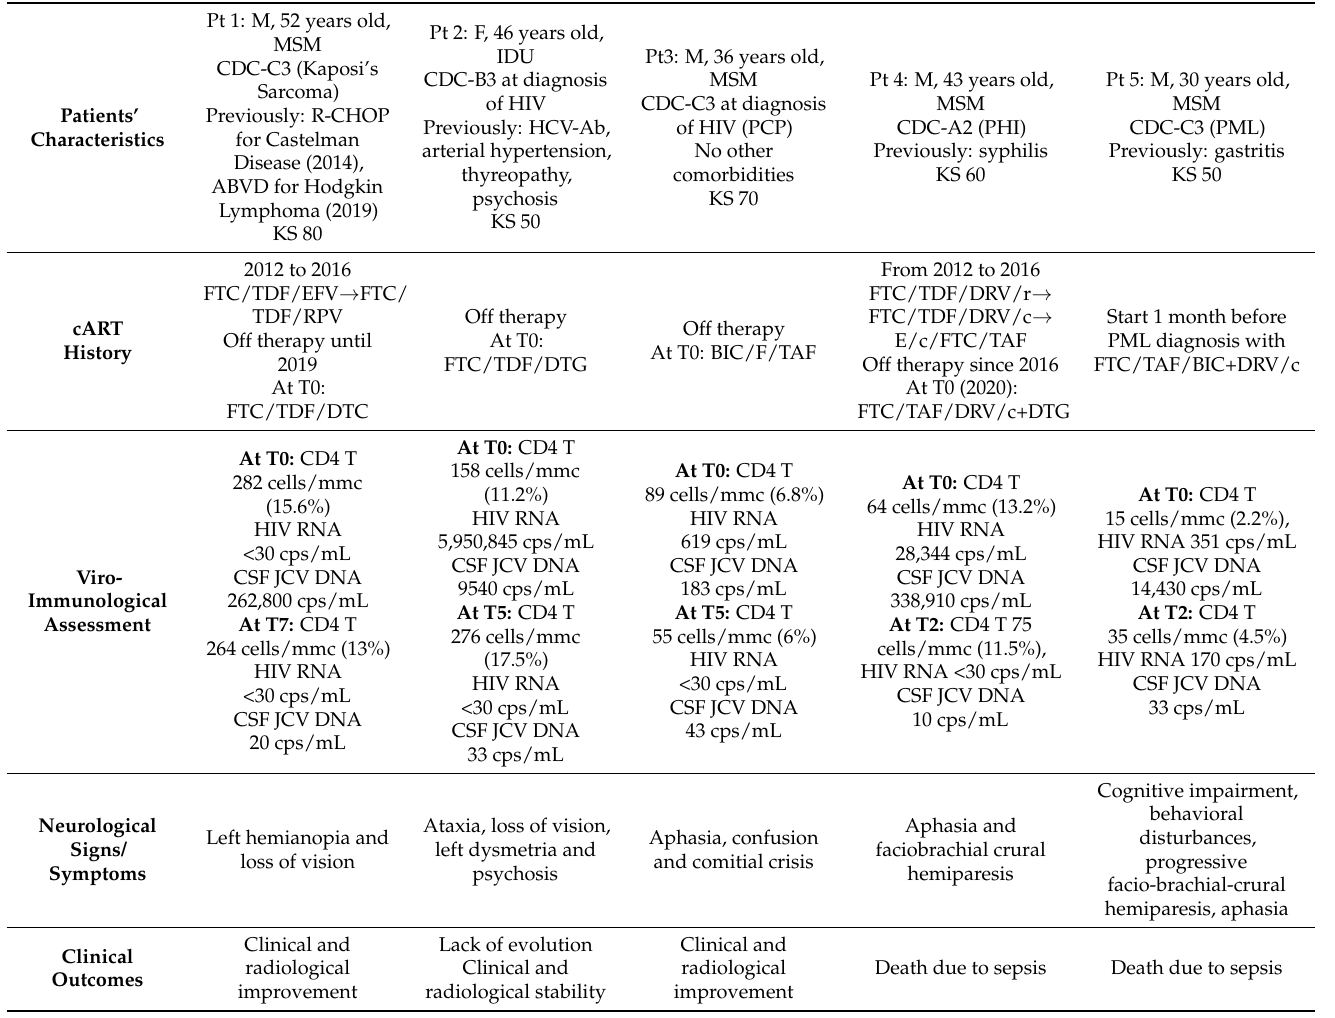
Table 1. Characteristics, cART history, viro-immunological assessment before and after pem- brolizumab treatment, neurological signs/symptoms and outcomes of